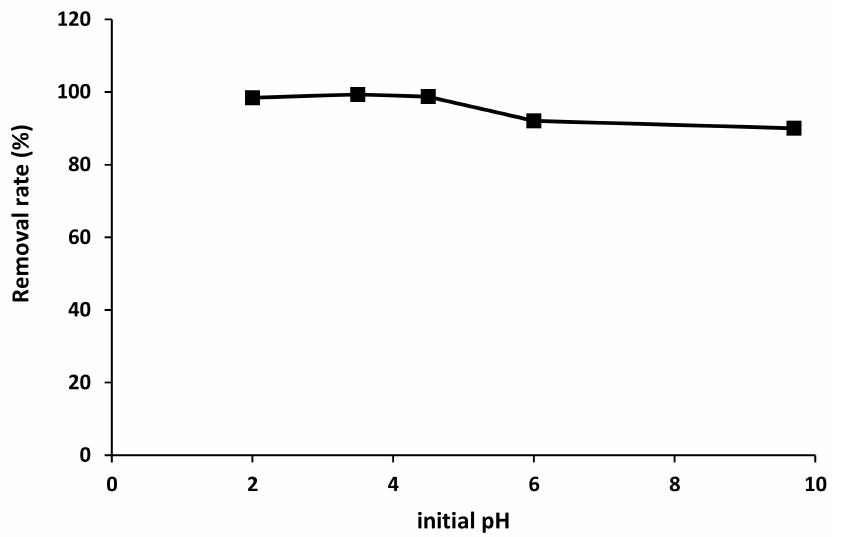
Figure 10. Effect of initial pH on the Fenton-like reaction with AC-Fe. Experimental conditions: [H 2 O 2 ] = 4 mmol/L, [TBO] 0 = 50 mg/L, [AC-Fe] = 1.2 g/L, reaction temperature = 20 ◦